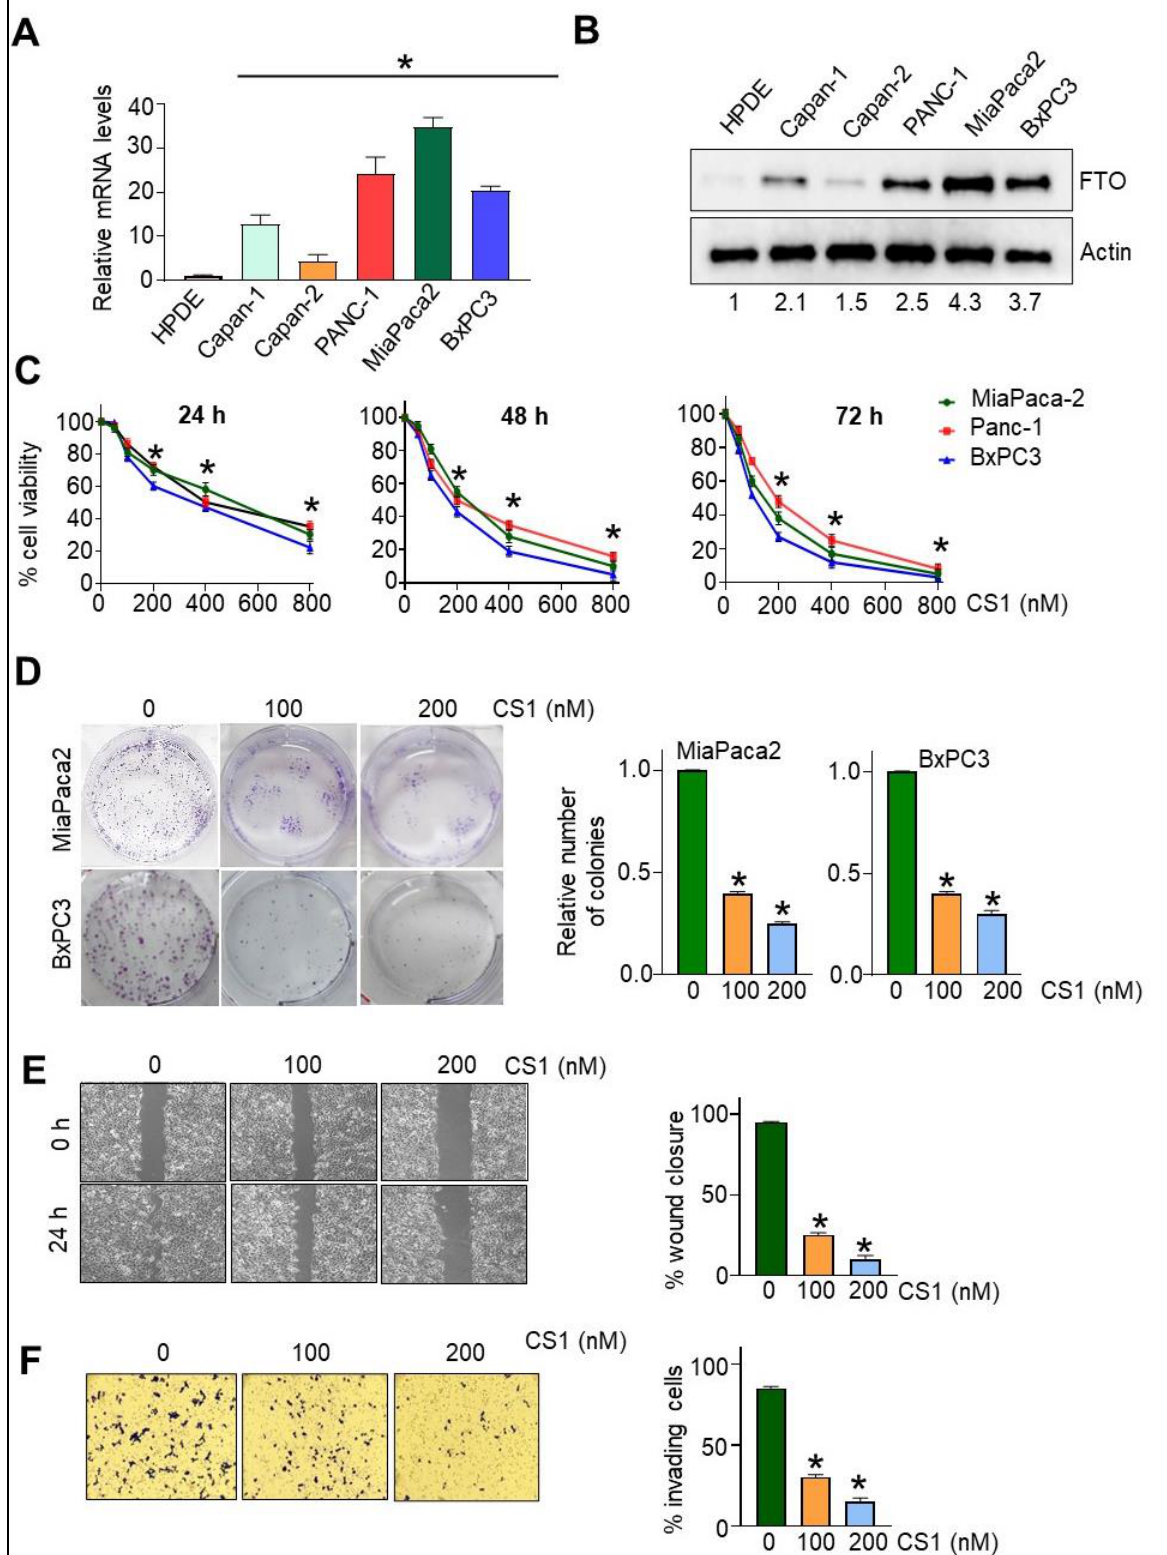
Figure 1. FTO is overexpressed in pancreatic cancer (PC) cells, and its inhibition hampers the growth, migration, and invasion of PC cells. ( A ) FTO mRNA levels as analyzed by qPCR. Data are normalized to actin and expressed as fold increase relative to HPDE cells (n = 3). * p < 0.05. ( B ) FTO protein